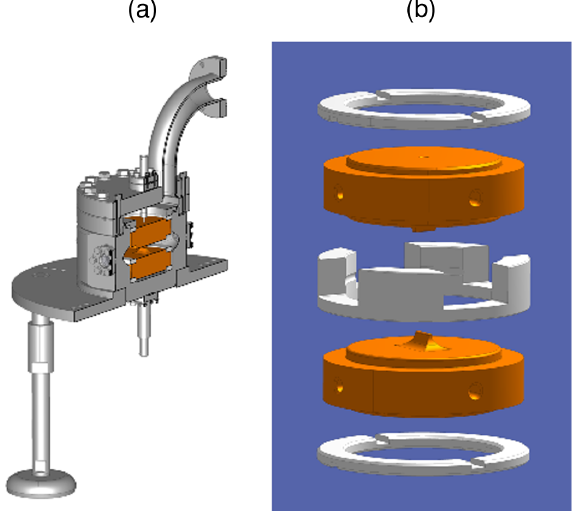
FIG. 1. (a) Sketch of the LES vacuum chamber and (b) detail of the mechanical assembly, holding crossed ridged electrodes.